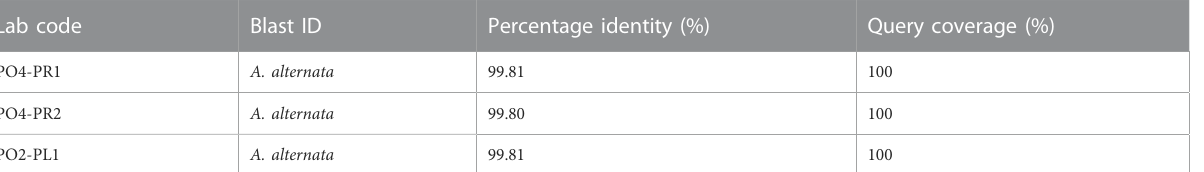
TABLE 1 Endophytic fungi isolated from S. birrea and Hypoxis species.